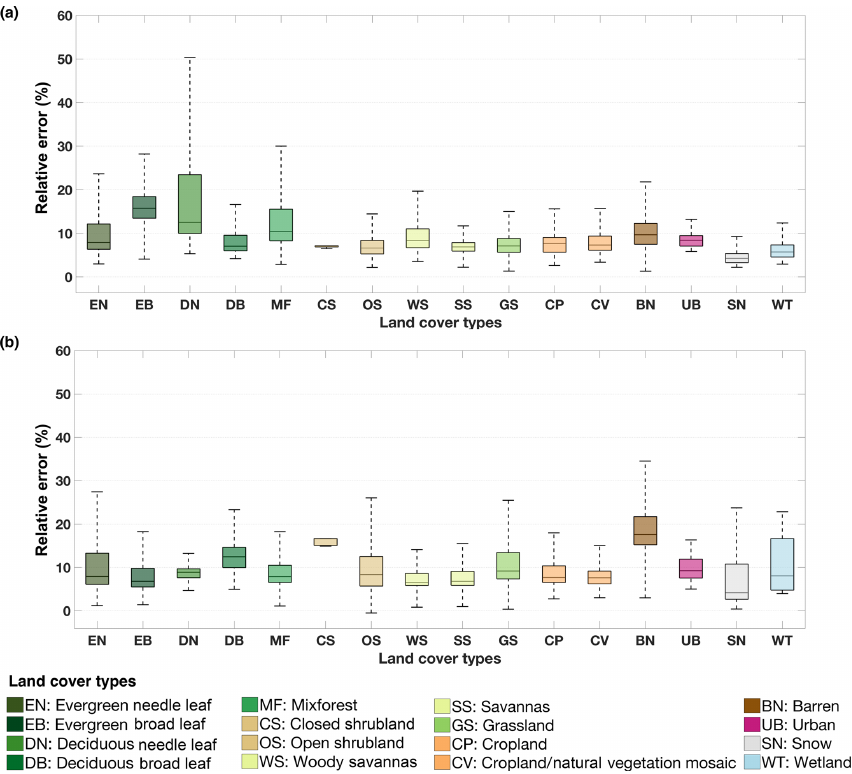
Figure 1. Averaged relative error of satellite-observed water content in different land cover types for (a) SMOS-derived soil moisture; and (b) GRACE-derived total water